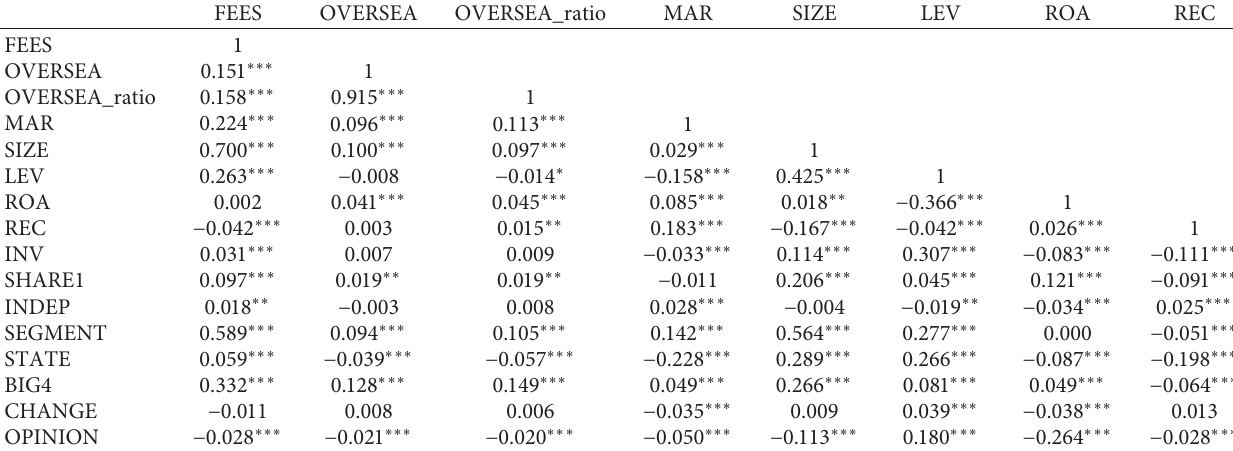
Table 4: Correlation coefficients (1).